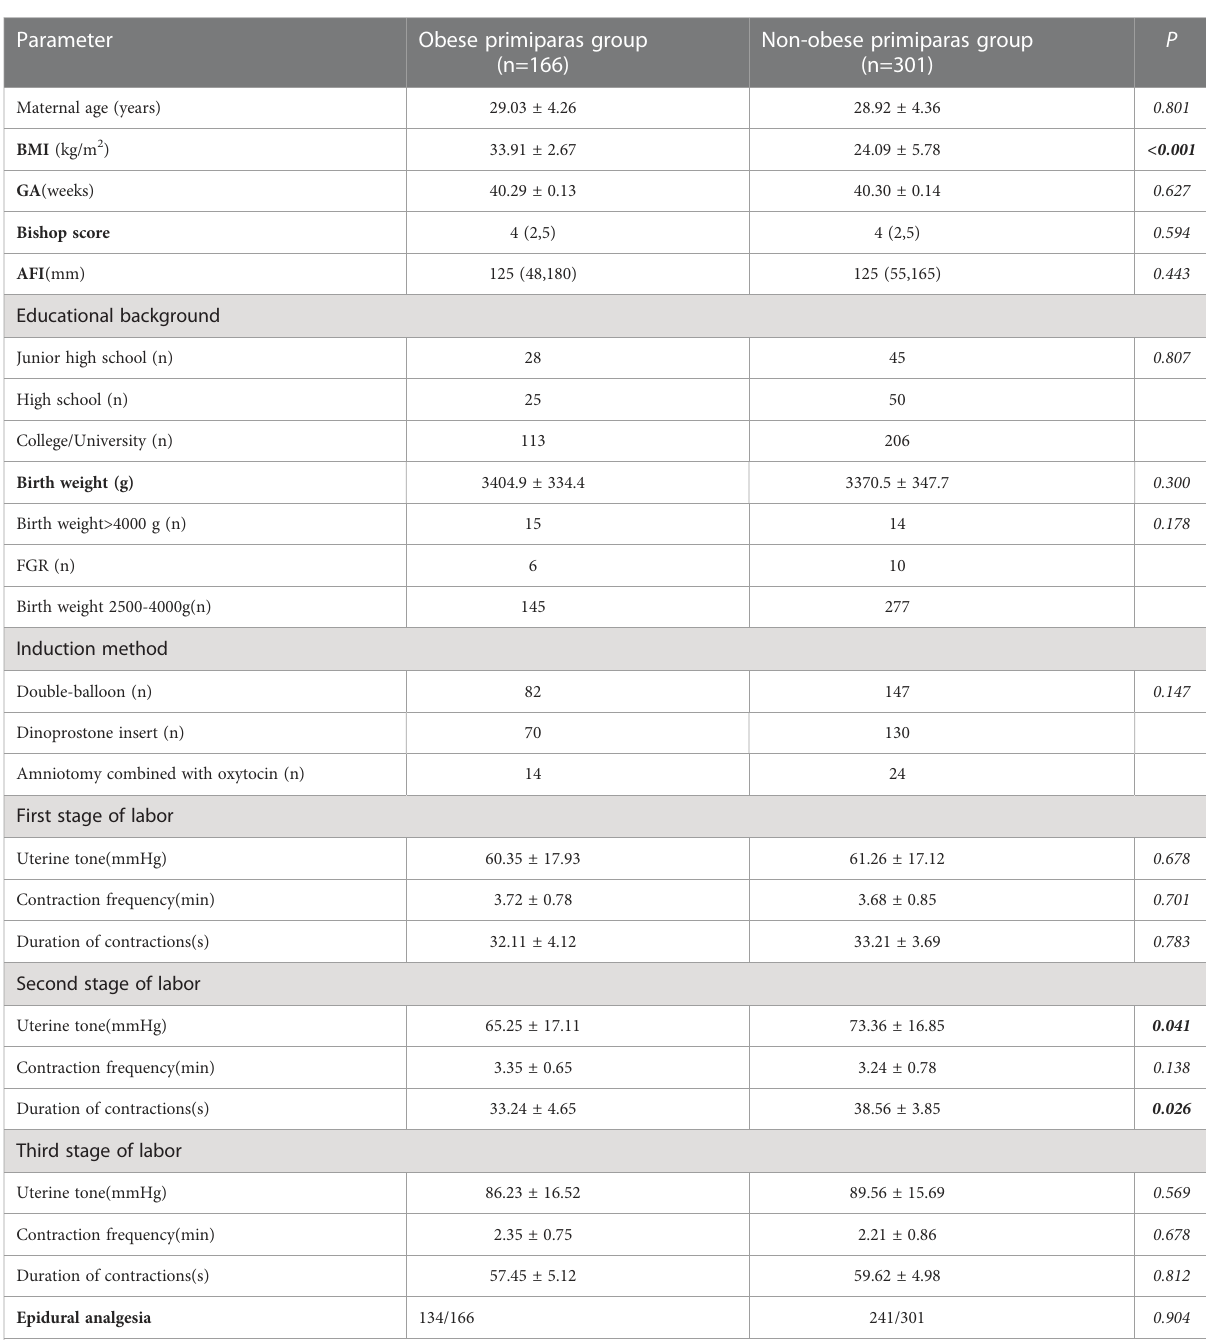
TABLE 1 Basic clinical